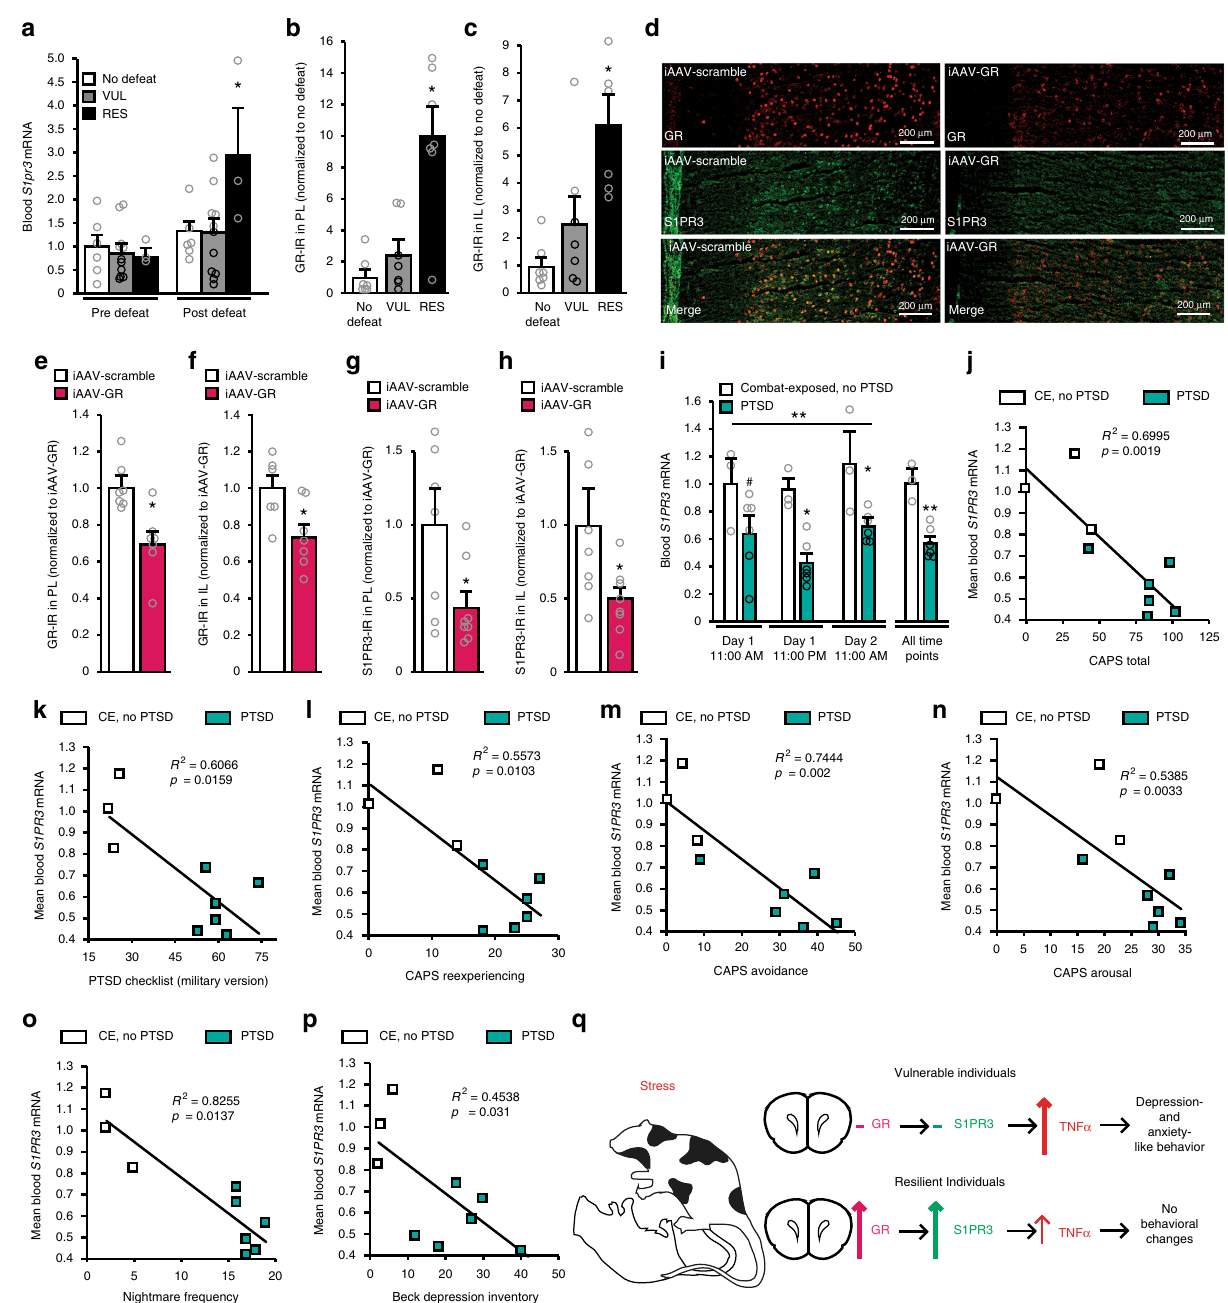
Fig. 4 S1PR3 expression is regulated by stress and predicts symptoms of PTSD. a Fold S1pr3 mRNA expression (normalized to pre-defeat ND controls) isolated from tail blood before and after defeat in ND ( n = 6), VUL ( n = 11), and RES ( n = 3) rats. GR-IR (percent area above threshold) in the b PL and c IL of ND, VUL, and RES rats ( n = 7/group). d Image of GR and S1PR3 in the mPFC of iAAV-scramble and iAAV-GR rats. Quanti fi cation of GR-IR (percent area above threshold) in e PL and f IL of iAAV-scramble and iAAV-GR rats ( n = 7/group). S1PR3-IR (percent area above threshold) in g PL and h IL of iAAV- scramble and iAAV-GR rats ( n = 7/group). i S1PR3 mRNA expression isolated from whole blood samples was reduced in combat-exposed (CE) veterans with PTSD ( n = 6 ) compared to CE veterans without PTSD ( n = 3) at three time points; mean of the three time points was also reduced. Time points are normalized to CE without PTSD mean at 11:00 AM on Day 1. Correlation between mean blood S1PR3 mRNA expression and j Clinician Administered PTSD Scale score, k PTSD checklist (military version), l re-experiencing symptom cluster of the CAPS score, m avoidance symptom cluster of the CAPS score, n arousal symptom cluster of the CAPS score, o nightmare frequency, and p Beck Depression Inventory in combat-exposed veterans with and without PTSD. q Model illustrating summary of results: vulnerable rats do not induce GR or S1PR3 expression, allowing social defeat to increase TNF α expression in the mPFC, which contributes to anxiety-like and depression-like behavior. Resilient rats induce GR and S1PR3 expression in the mPFC, thereby attenuating TNF α expression and preventing anxiety-like and depression-like behavior. Bars represent mean + SEM. * p < 0.05, ** p < 0.01, # p < 0.07. For a * indicates Bonferonni post-hoc difference from pre-defeat groups (two-way repeated measures ANOVA). For b , c * indicates Tukey post-hoc difference from ND control and VUL rats (one-way ANOVA). e – h Student ’ s t -test. For i * and # represent Bonferonni post-hoc differences compared to time-matched controls (two-way repeated measures ANOVA), horizontal bar represents group difference across all three time